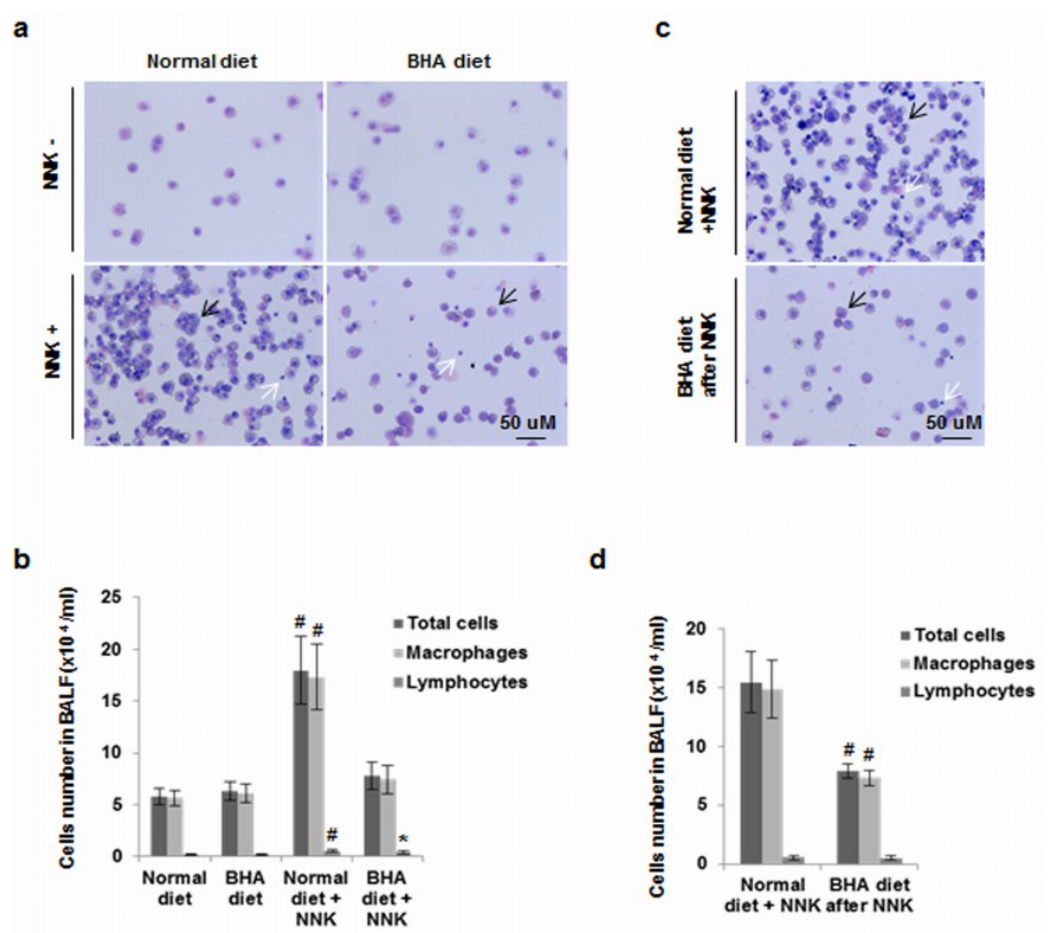
Figure 4. BHA blocks NNK-induced increase of macrophages in BALF. ( a ) A/J mice were maintained on normal or BHA diet for 2 weeks prior to NNK injection. BALF cells were prepared and stained with Wright and Giemsa after two weeks after NNK treatment. Representative images are shown; ( b ) Quantitative analysis of ( a ) is shown. The percentages of leukocyte types in BALF were determined by counting 400 leukocytes in a randomly selected portion of the slide under light microscopy; ( c ) A/J mice were maintained on normal or BHA diet 1 week after NNK treatment. Representative images of BALF cells collected 2 weeks after the last NNK dose. Represetitive Wright-Giemsa stainings are shown; ( d ) Quantitative analysis of ( c ) is shown. Black arrow: macrophage; White arrow: